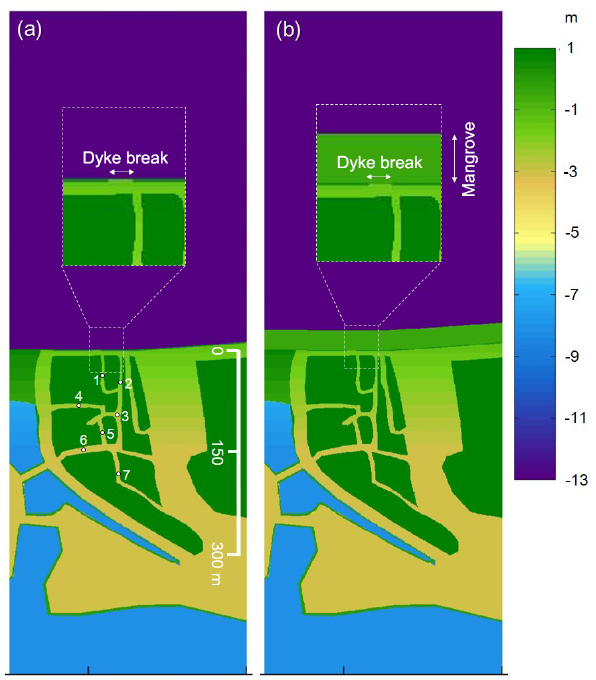
Figure 7. Elevation topography used in the simulation, measured from the highest sea level which occurred between September 2015 and February 2016. (a) Present ground elevations and buildings (dark green). (b) Present elevations, together with a 20m man- grove belt in front of the dyke. Notes: the enlarged view focuses on the dyke-break section, assumed to be 20m long. The numbers 1 through to 7 indicate the output points of the computational